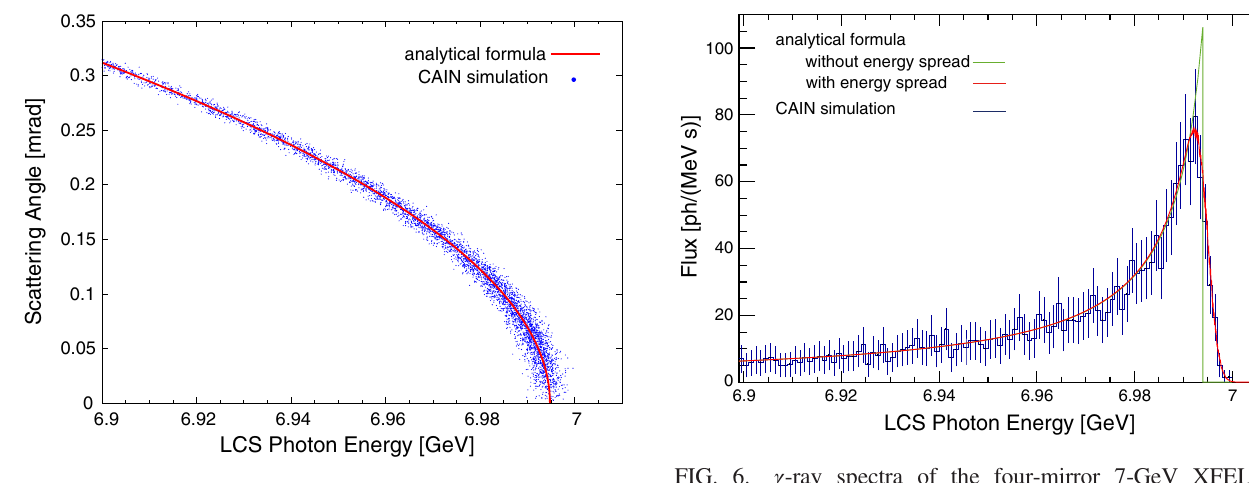
FIG. 5. Correlation of γ -ray energy and scattering angle in the two-mirror 7-GeV XFELO- γ calculated by an analytical formula without electron energy spread (red line) and numerical simu- lation by CAIN (blue dots).